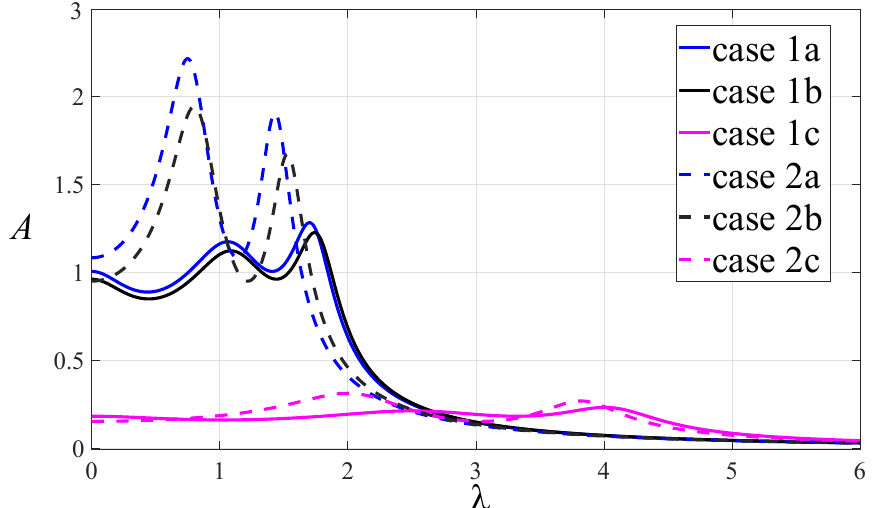
Figure 4. The normalized amplitude–frequency curves for different cases.